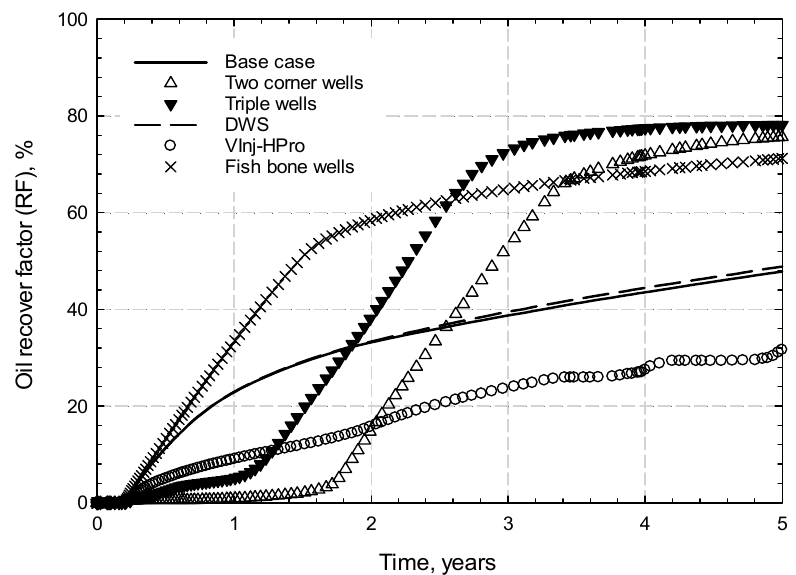
Figure 13. Oil recovery factors of different well patterns applied in the reservoir with a bottom water zone, including two corner wells, triple wells, downhole water sink well (DWS), vertical injectors with horizontal producer (VInj-HPro), and fishbone well.